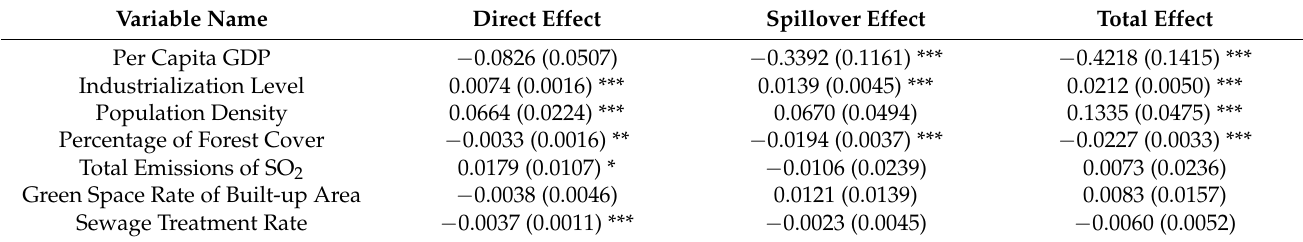
Table 6. Spillover effect analysis (using the Spatial Durbin